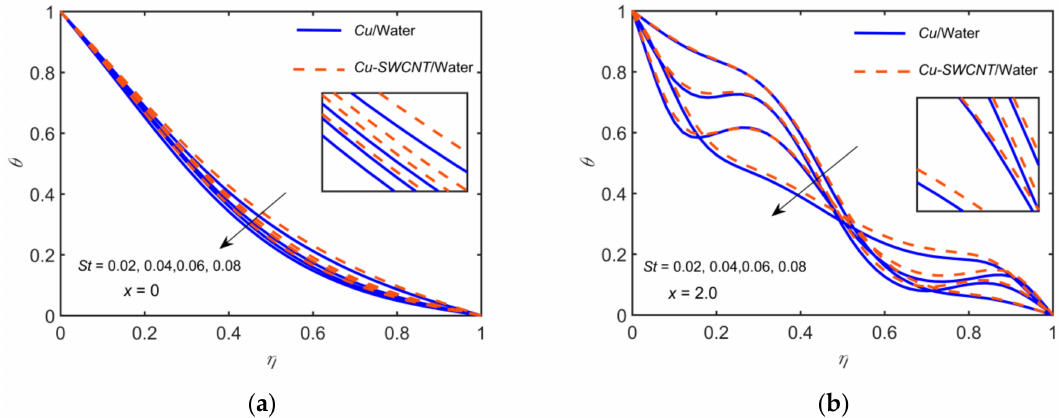
Figure 11. Comparison of Cu /water and Cu – SWCNT /water for the temperature profiles for t = 0.02, 0.04, 0.06,and 0.08 with M = 5, Pr = 1, Rd = 0.2, Re = 700, φ = 0.02, and t = 0.25 at ( a ) x = 0 ( b ) x = 2.